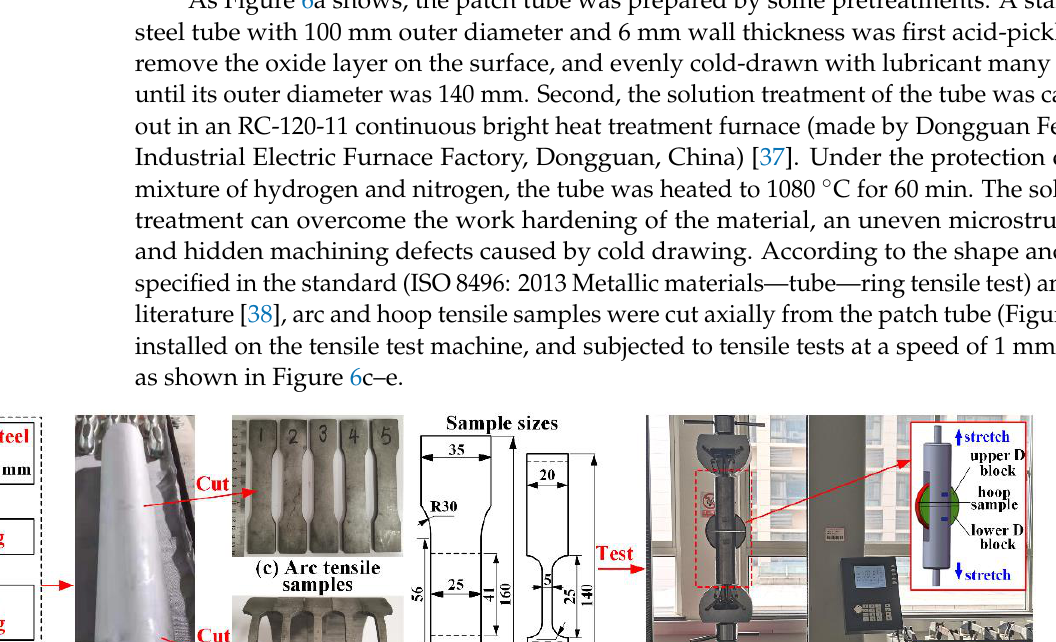
Figure 7. Composition and hardness analysis of AISI 321. Table 1. Material mechanical property parameters. Material